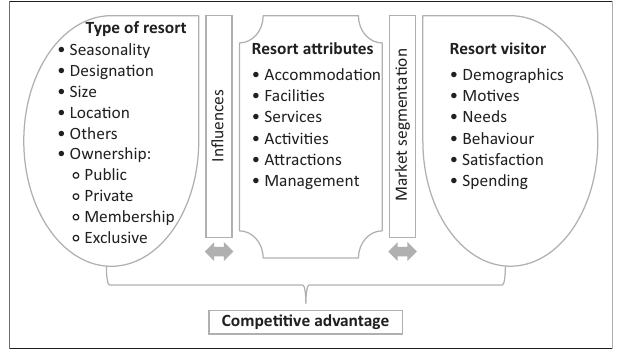
FIGURE 1: Resort tourism in South Africa. TABLE 2: Previous research on the travel motives to visit resorts.